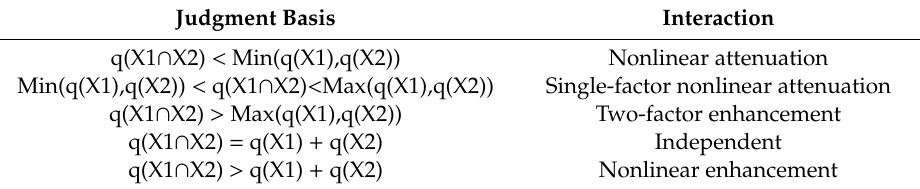
Table 3. Types of Interactions between Driving Factors.